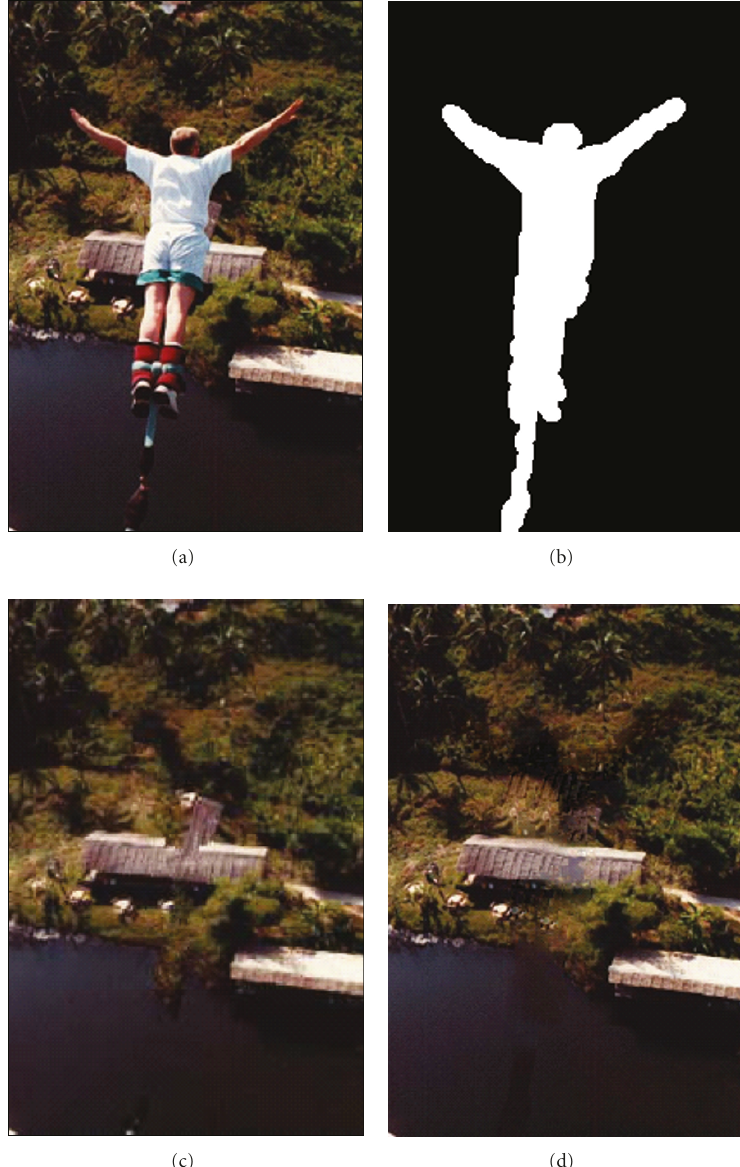
Figure 14: A given image for large object removal (a), the mask image (b), the exemplar-based inpainting method [4] (c), and the proposed method